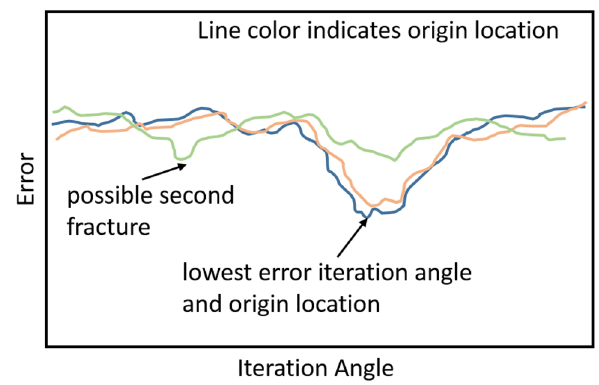
Fig. 4 Conceptual sketch of an error versus iteration angle plot. The colors of the lines each represent a different origin location. The reductions in error can possibly signify the existence of a fracture plane with that iteration angle from the assumed origination orienta- tion